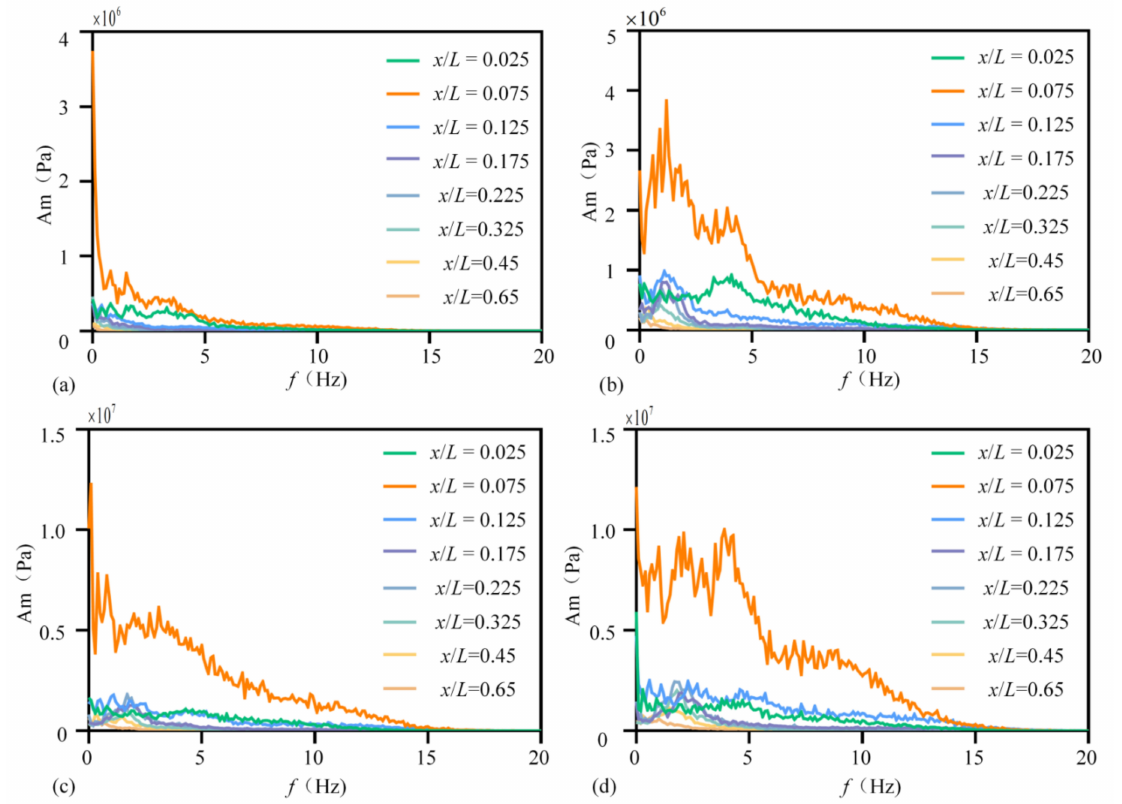
Figure 12. ( a ) k = 0.0134; ( b ) k = 0.0223; ( c ) k = 0.0308; ( d ) k = 0.0403, the Hilbert marginal spectrum of fluctuating pressure at the characteristic point of TP4 bottom